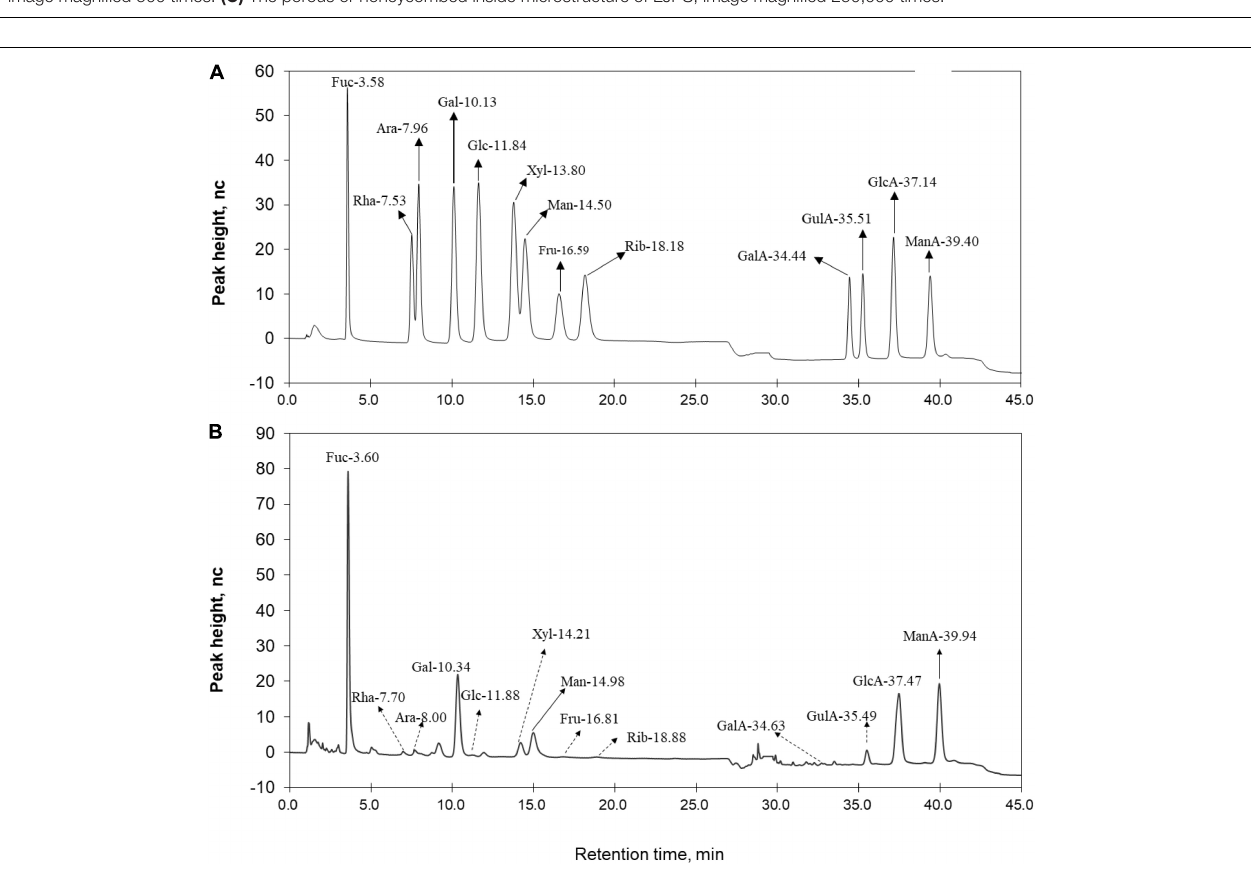
FIGURE 1 | Scanning electron microscope (SEM) images of LJPS. (A) An overview of the uniform and flat surface of LJPS powder, image magnified 200 times; (B) image magnified 500 times. (C) The porous or honeycombed inside microstructure of LJPS, image magnified 250,000 times.